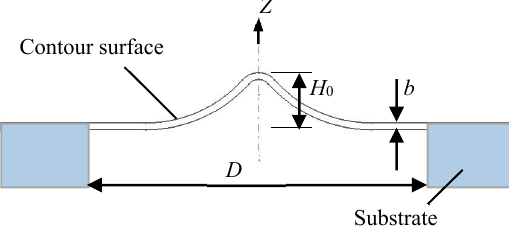
Figure 1. Schematic diagram of the microresonator with the bionic structure of the tympanic membrane.